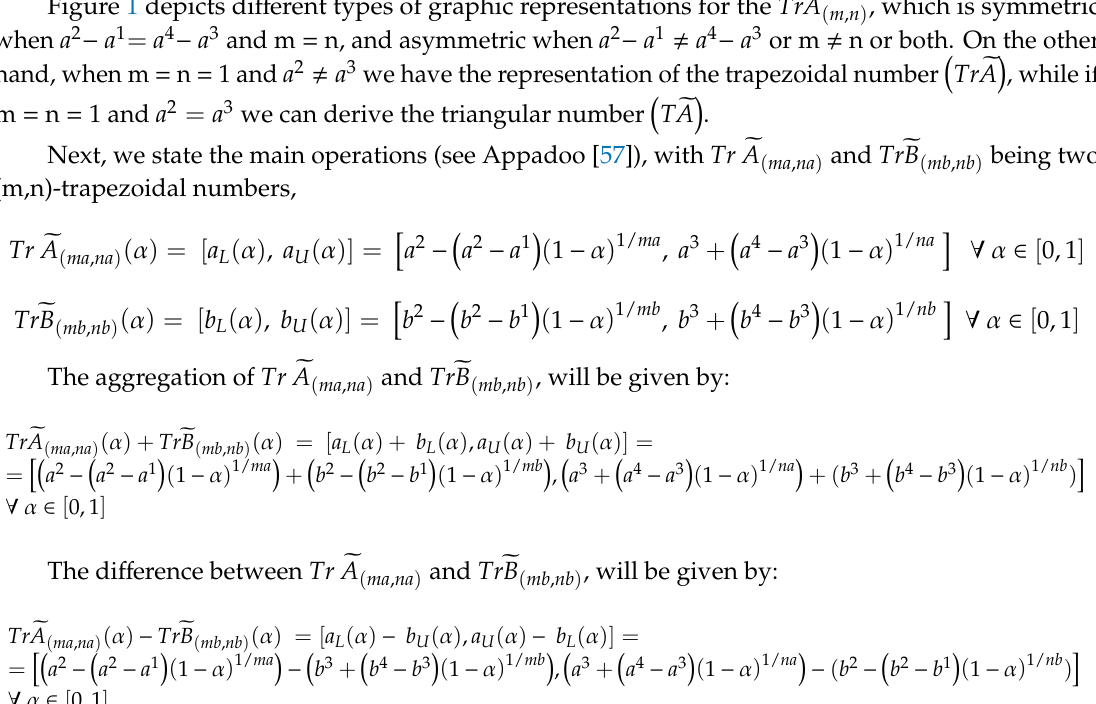
Figure 1. Membership function of Tr (cid:101) A ( m , n )